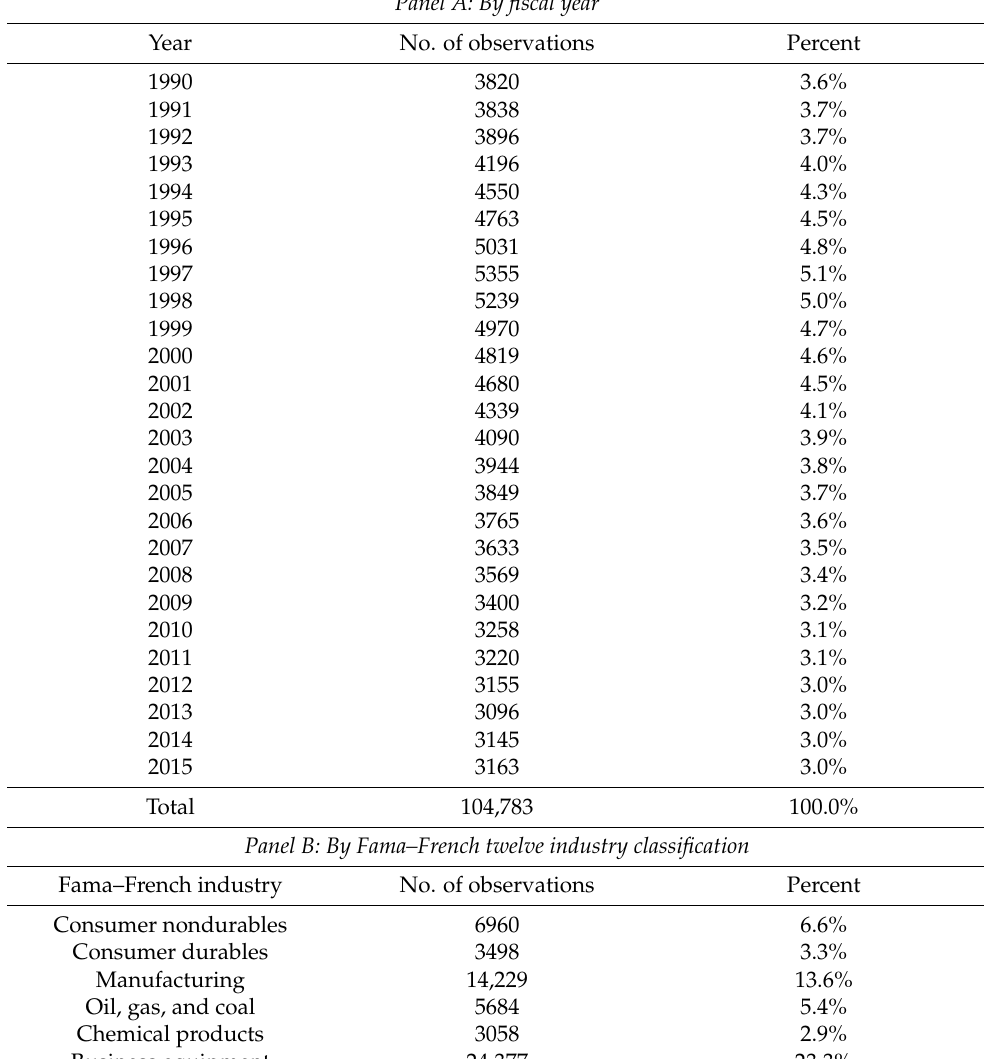
Table 1. Sample distribution. Panels A and B present the distribution of sample firm-year observa- tions by fiscal year and by firm industry classification, respectively. Our sample contains 104,783 firm-year observations from 1990 to